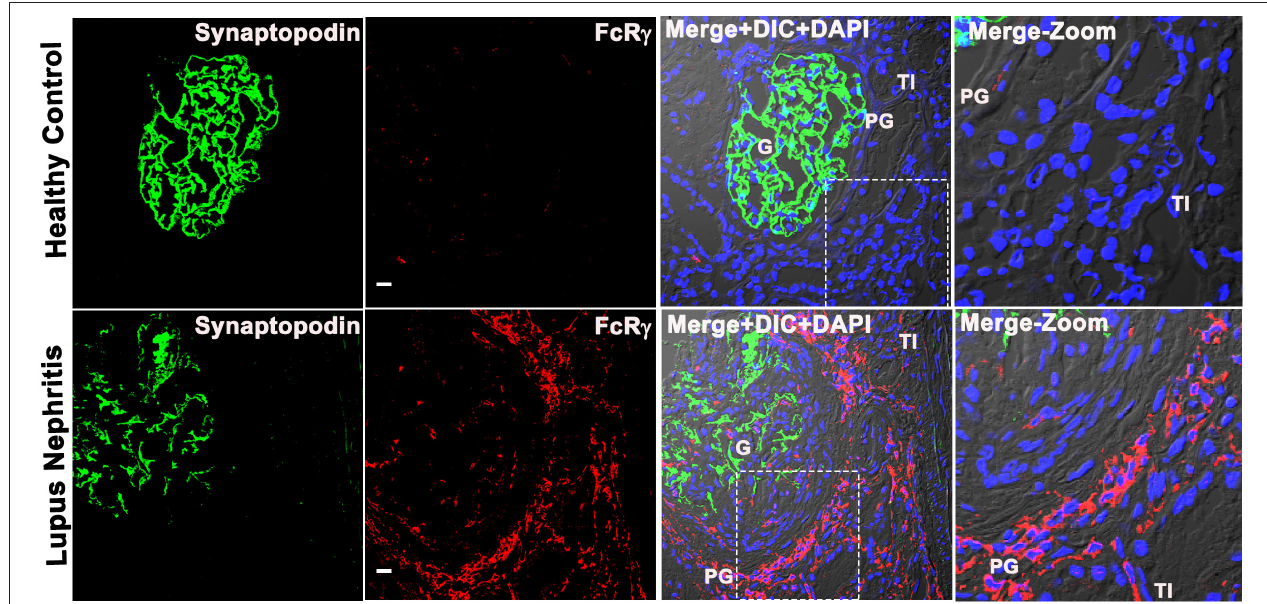
FIGURE 2 | Fc receptor gamma chain is highly expressed in the patient’s kidney with LN, and its expression is confined to the periglomerular (PG) region. Three color confocal IF image that is representative of 5 human LN kidney showing the expression of FcR γ (bottom row) in the PG region of the kidney and no expression in the representative of the three HC kidneys (top row). The third column shows merged images of the first 2 columns, i.e., synaptopodin (podocyte marker in green) was used as a landmark for G in the first column, FcR γ (red) in the second column plus differential interference contrast (DIC) microscopy and DAPI staining of nuclei (blue). The fourth column shows the zoomed image of the third column highlighted using a dotted square. The scale bar in the second column represents 20 µ